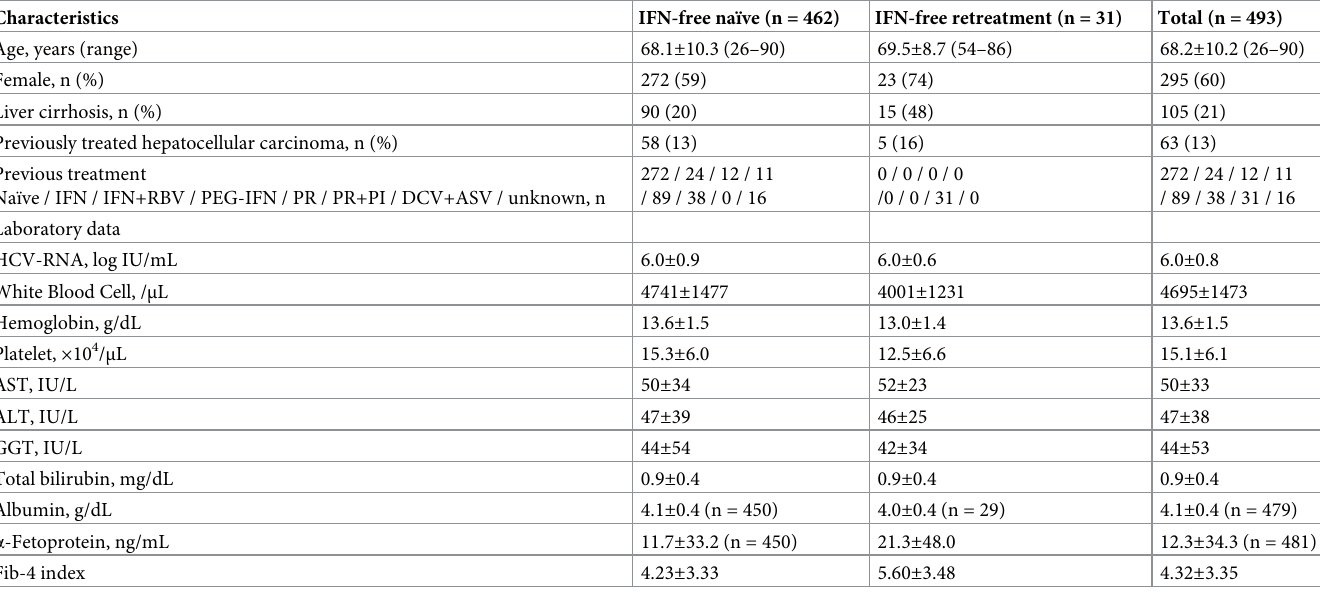
IFN, interferon; RBV, ribavirin; PEG-IFN, pegylated-IFN; PR, PEG-IFN and RBV; PI, protease inhibitor; DCV+ASV, daclatasvir+asunaprevir; IL28B SNP, Interleukin 28B single nucleotide polymorphism; AST, aspartate transaminase; ALT, alanine aminotransferase; GGT, γ -glutamyltransferase. Data are shown as the mean ± SD unless otherwise